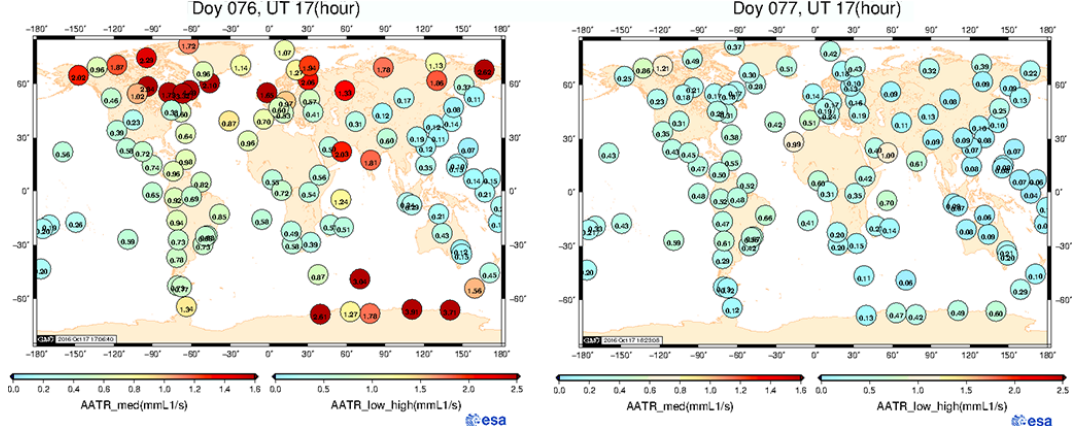
Figure 20. Global AATR for 17 (left) and 18 (right) March 2015 at 17:00 extracted from MONITOR products (http://monitor.estec.esa.int).